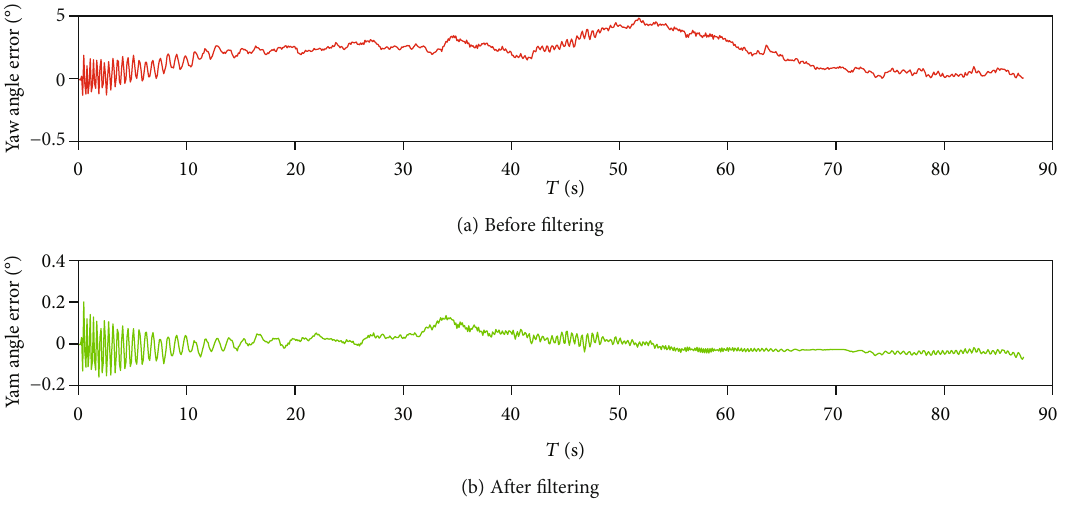
Figure 8: Comparison of yaw angle error before and after fi ltering.